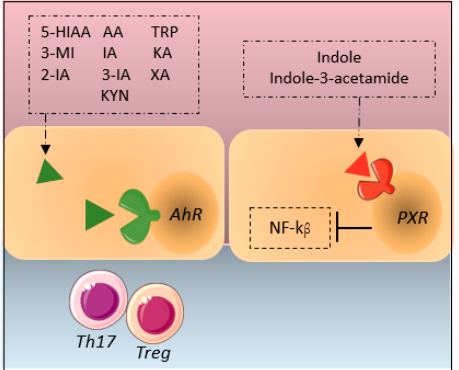
Figure 4. Interactions of tryptophan metabolites with innate immune receptors. Abbreviations:5- HIAA; 5-hydroxyindoleacetic acid, 3MI; 3-methylindole, 2IA; indole-3-aldehyde 3IA;